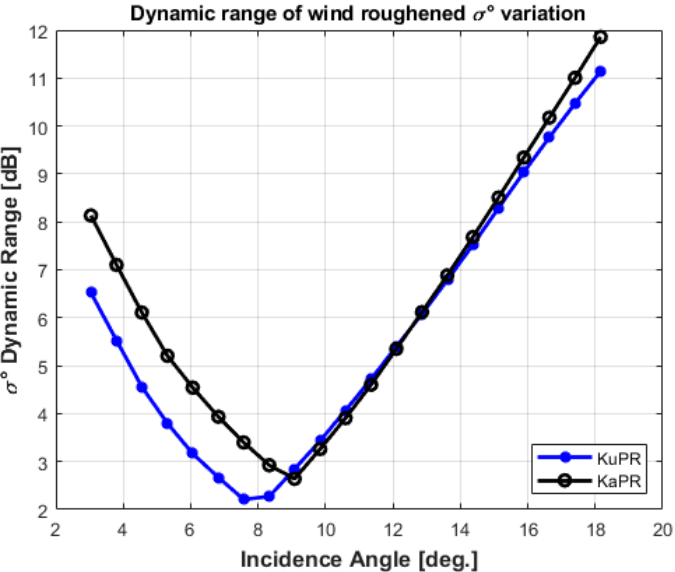
that the two GMF's are similar and are applicable for a WS range of 3 – 20 ms −1 and for all Figure 8. Dynamic range of wind roughened σ 0 (in dB) for Ku and KaPR for WS = 1–20 ms − 1 . EIA beam positions.